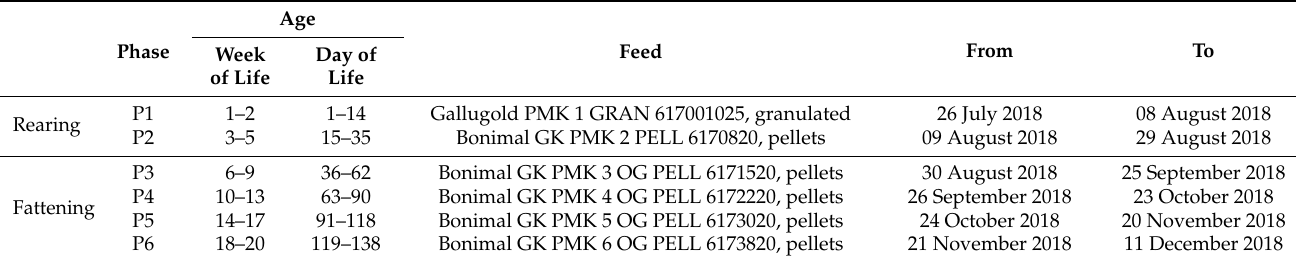
Figure 1. Experimental setup showing the distribution of the three breeds in the barn sections (1 to 24) during rearing (=1st to 35th day of life; top) and fattening (=36th to 138th day of life; bottom). Only the right wing was used during rearing. A, B, C, and D indicate the locations of the data logger sensors that measured the temperature and relative humidity in the barn. B.U.T. = British United Turkey, V = variant. Table 1. Classification of rearing and fattening phases (P) and the feeding during rearing and fattening (feed from BayWa AG FM/TH Franken 164, Bamberg, Germany).